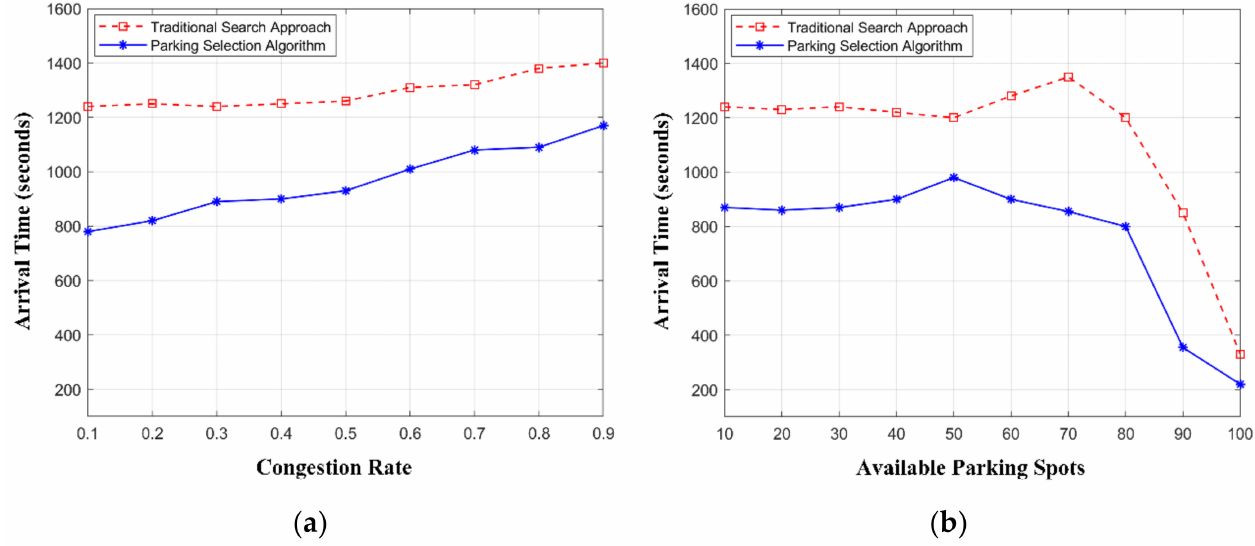
Figure 9. The arrival time using parking selection algorithm and traditional search approach, considering: ( a ) different available parking spots, and ( b ) different congestion